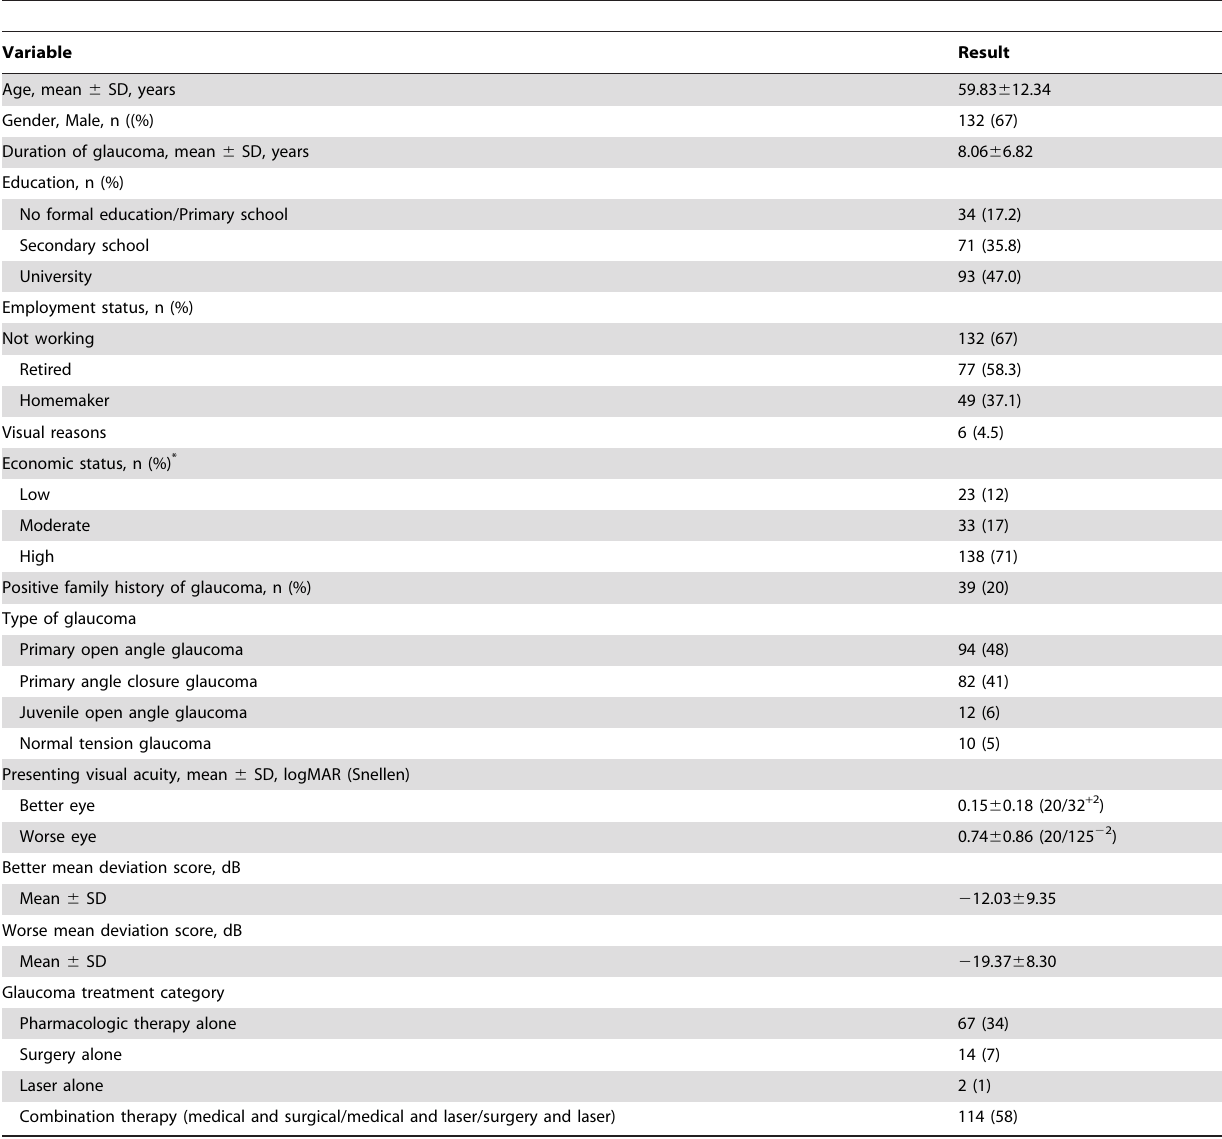
Table 2. Sociodemographic and clinical characteristics of 198 participants with glaucoma who completed the Patient Health Questionnaire-9.